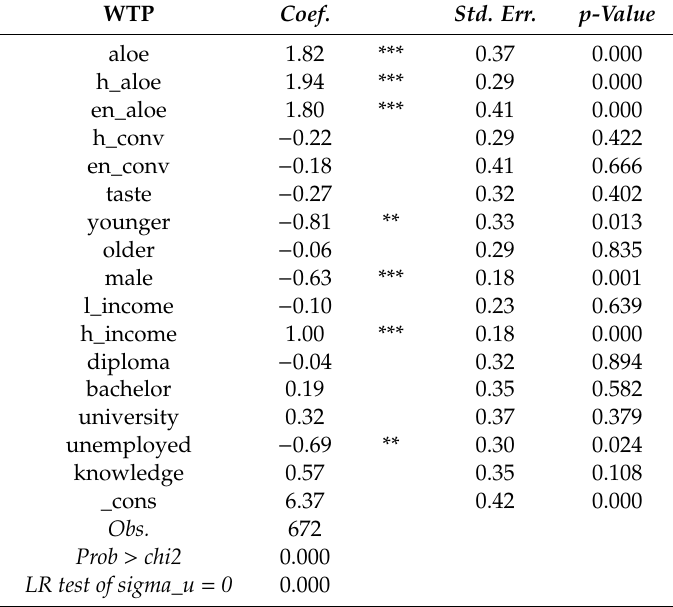
Table 3. Tobit model with random e ff ect for the WTP for the fruit compote (Model 1). WTP